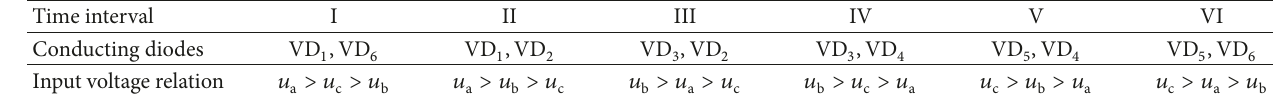
Table 1: Conduction situations of six diodes.